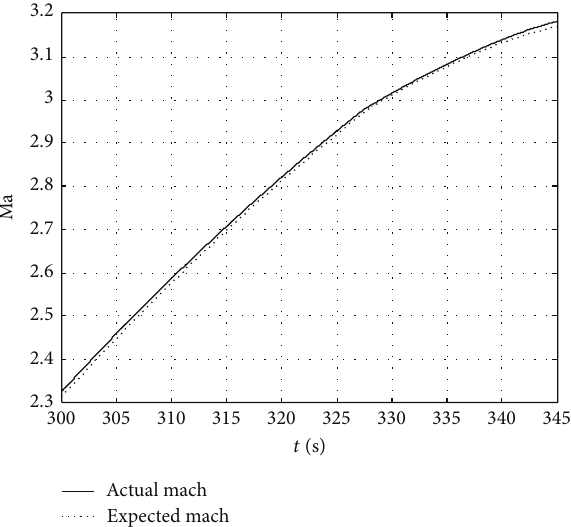
Figure 17: Simulation result of flight path angle.